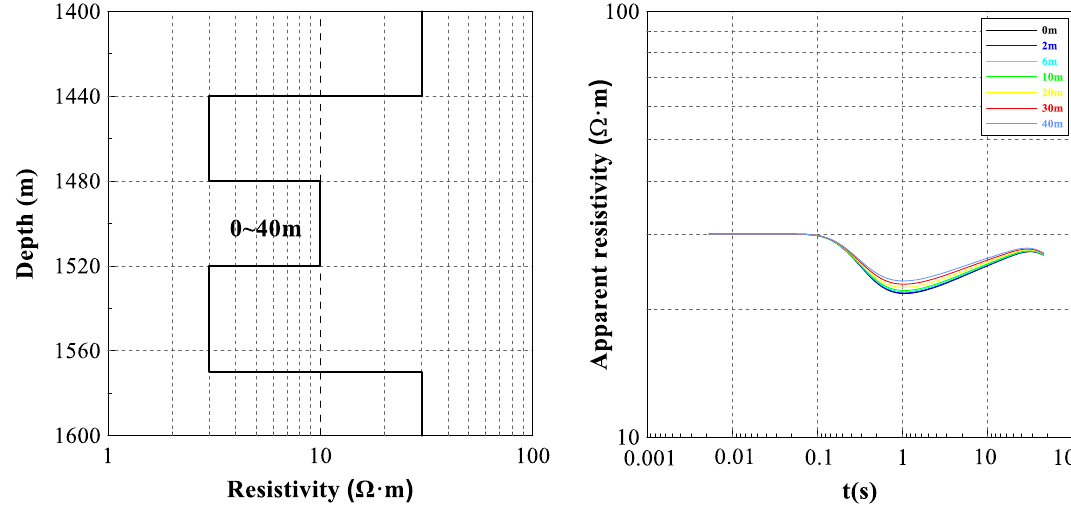
Fig. 3 TEM 1-D forward results (left: 1-D model, right: the apparent resistivity results with the thickness variation of oil-bearing